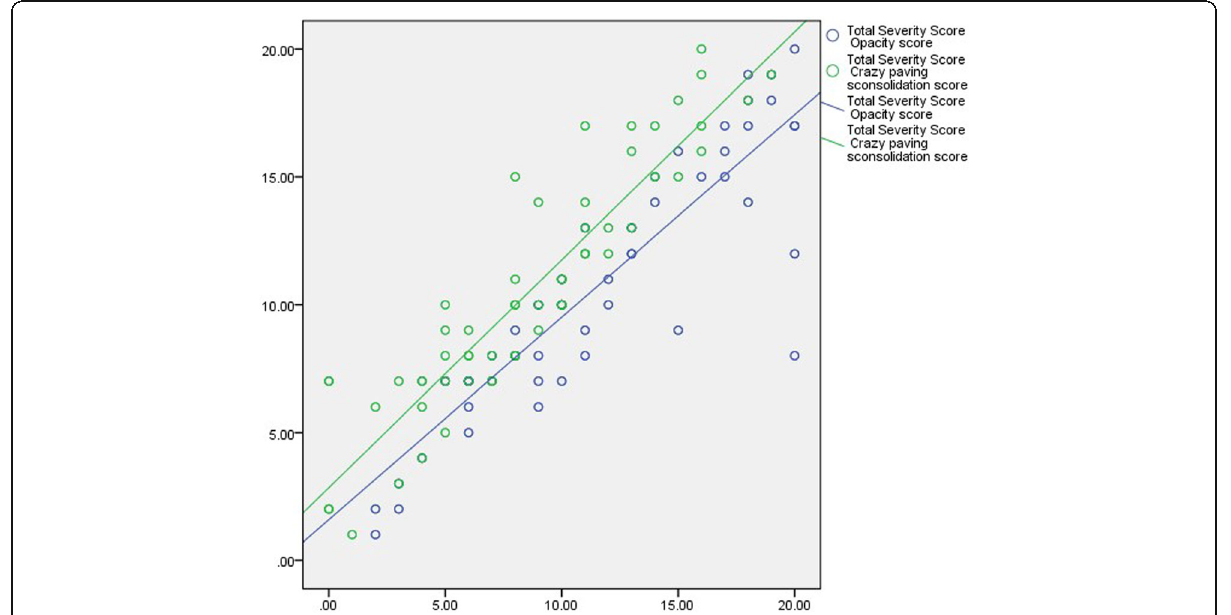
Fig 7 Scatter plot of the total severity score with the opacity score and crazy-paving consolidation